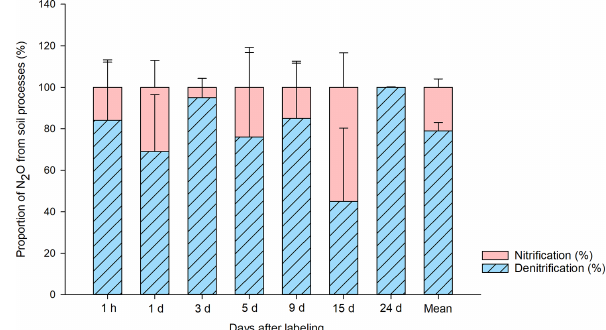
Figure 4. Proportion of N 2 O (%) produced in the bare peat (BP) soil by denitrification and nitrification during the study period. The source partitioning was done following the previously described single- and double- 15 N-labeled ammonium nitrate method (Baggs et al., 2003). The source contribution is calculated from 15 N 2 O emitted and the 15 NO − pool in the soil, in relation to the total 3 amount of 15 N label applied to the soil (Wrage et al., 2005). The cal- culation was done individually by plot ( n = 3) and sampling point ( n = 7), and the average of three plots is reported with respect to days after labeling. The mean value for the entire 24d sampling period is also